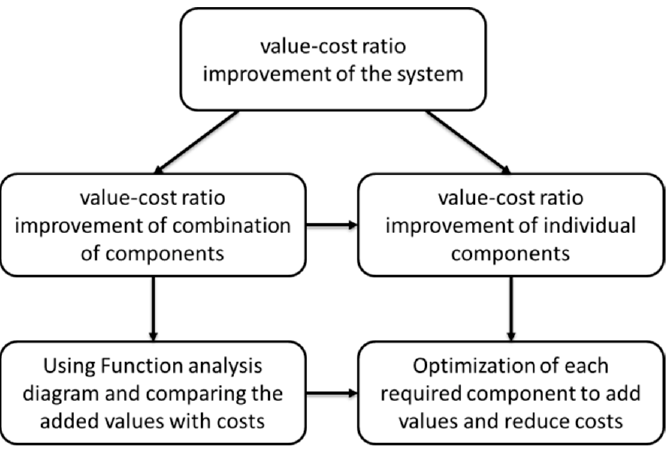
Figure 1. Diagram of the value–cost ratio improvement of a typical engineering system.